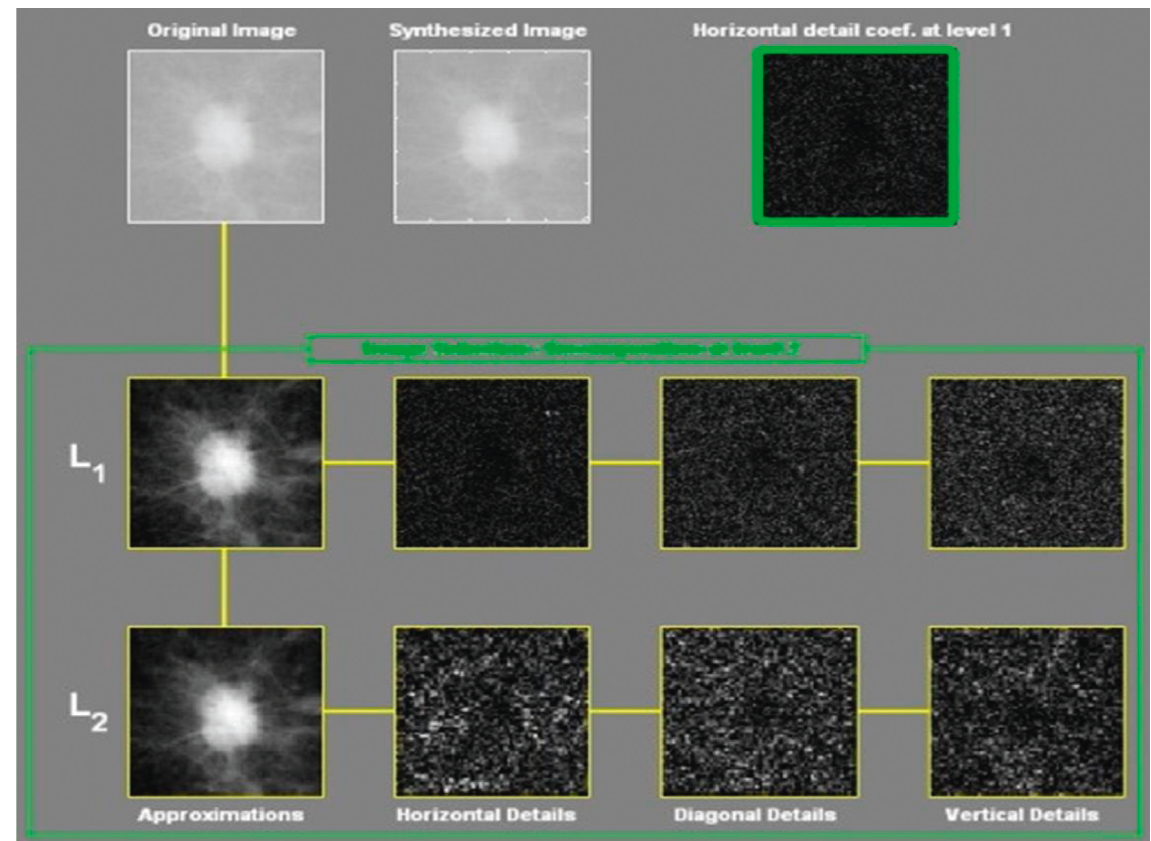
Figure 7: A view of Haar wavelet